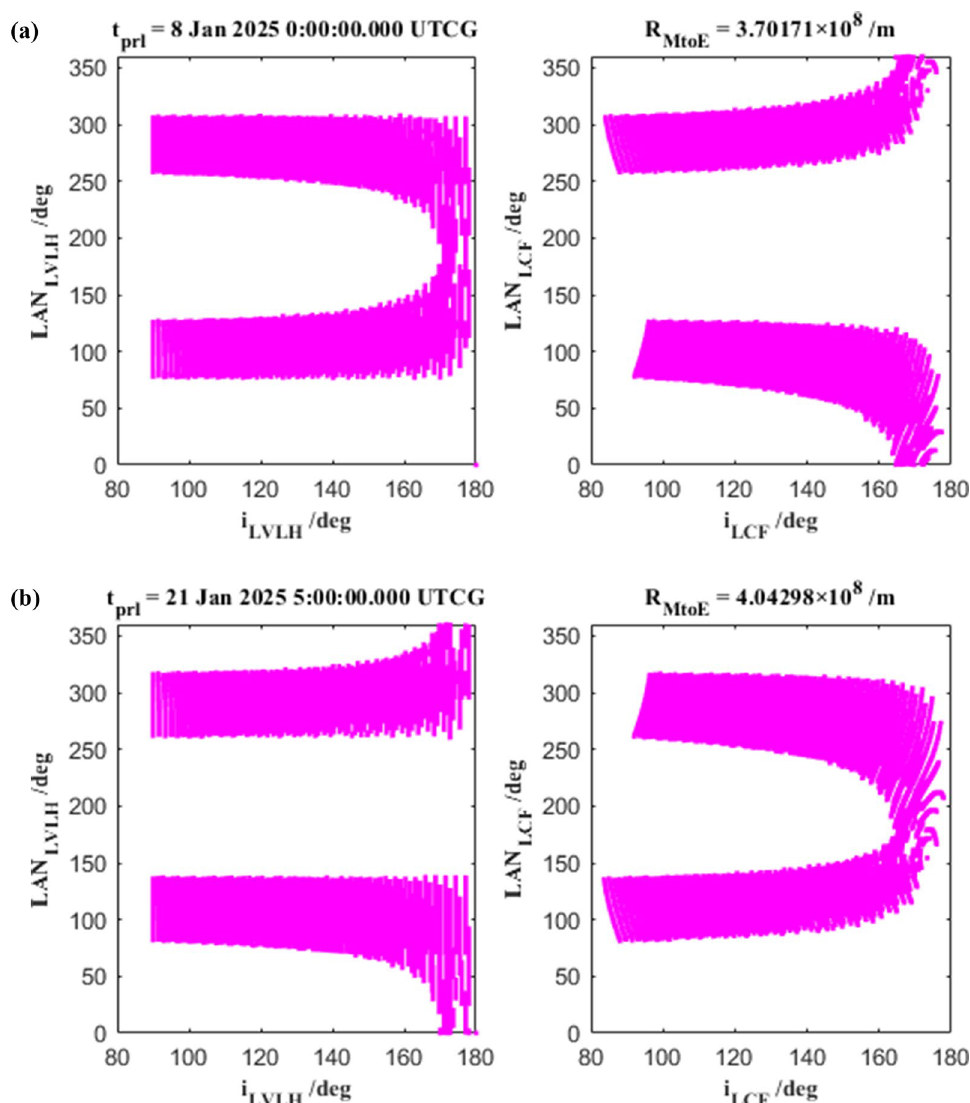
Fig. 9 a The inclination and LAN in LVLH frame and LCF frame with the nearest value of the Earth–Moon distance. b The inclination and LAN in LVLH frame and LCF frame with the farthest value of the Earth–Moon